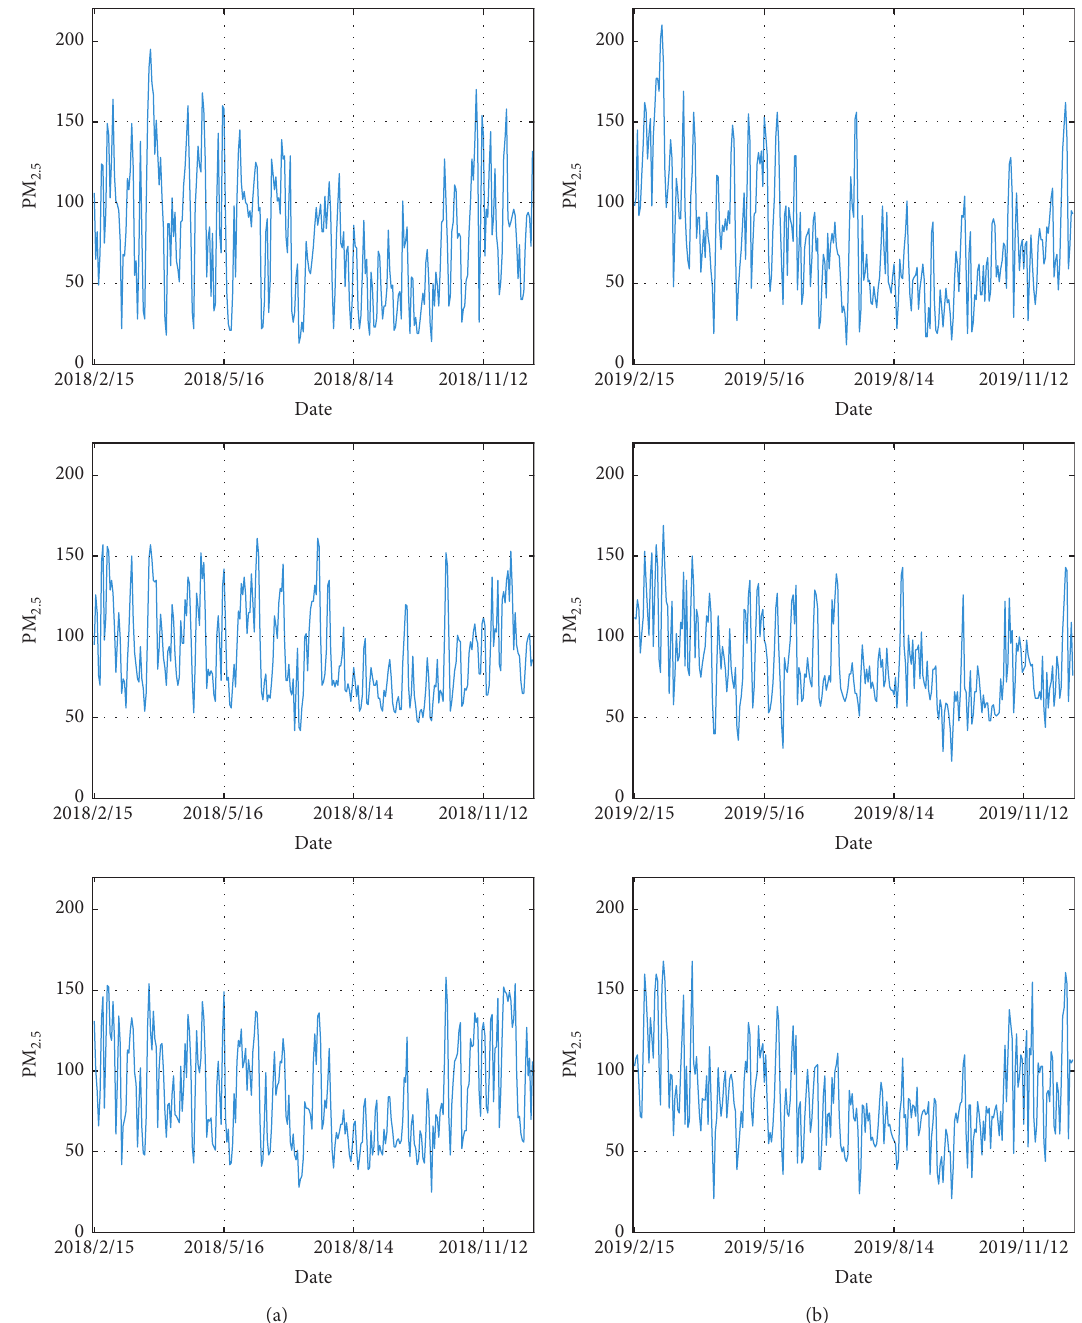
Figure 6: Time series of PM (a) before and (b) after implementation of the law. From top to bottom are Seoul, Busan, and 2 . 5